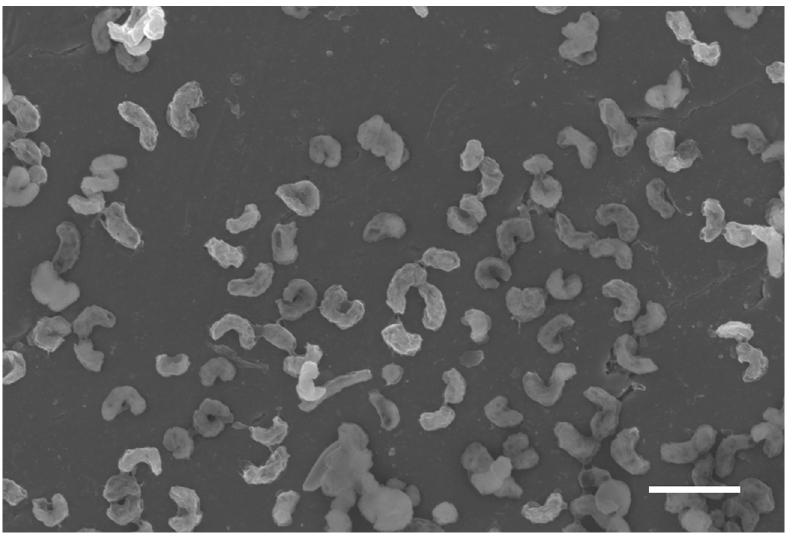
Figure 1. SEM micrograph of Leptospirillum sp. CC. Cells were grown on ferrous iron at 40°C for 5 days. Bar represents 2 μ m.